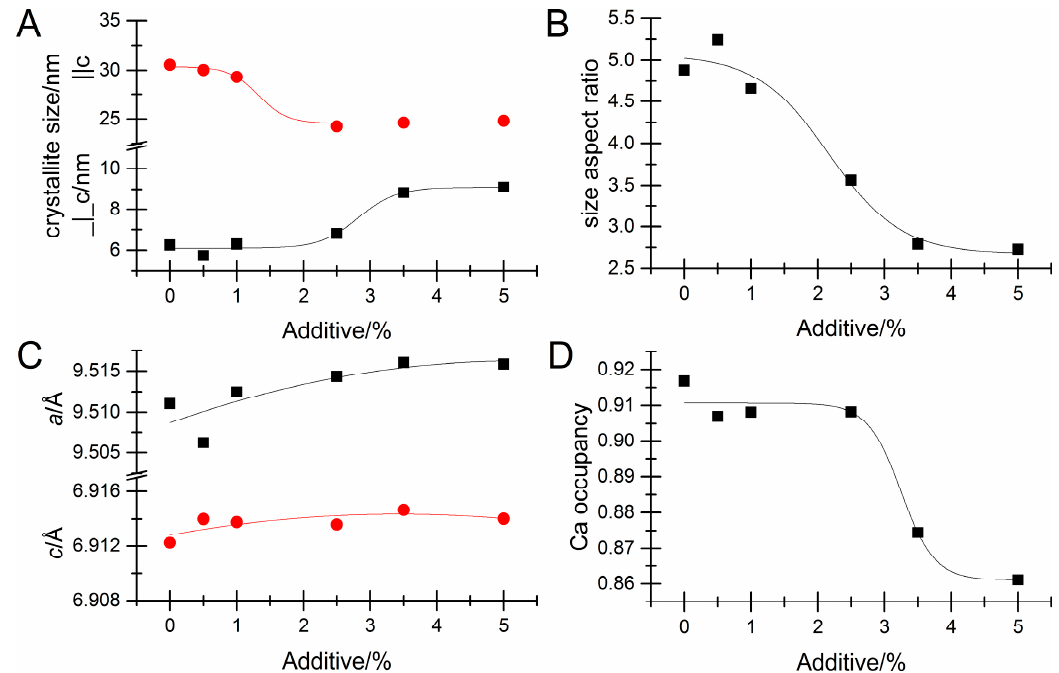
Fig.3 Figure 3. Values at long times of selected crystallographic parameters as a function of amount of added pyrophosphate. Lines are, in all cases, guides to the eye. The pyrophosphate concentration is given as a molar percent of the calcium concentration. ( A ) shows crystallite size along (red) and perpendicular (black to the c -axis); ( B ) shows the crystallite size aspect ratio (size|| c /size ⊥ c ); ( C ) shows the lattice constants as a function of additive concentration while ( D ) gives the occupancy of the calcium sites in the apatite unit